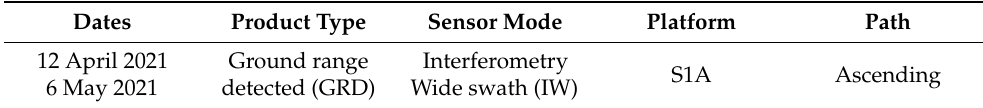
Table 1. Technical attributes of Sentinel-1 data used for this